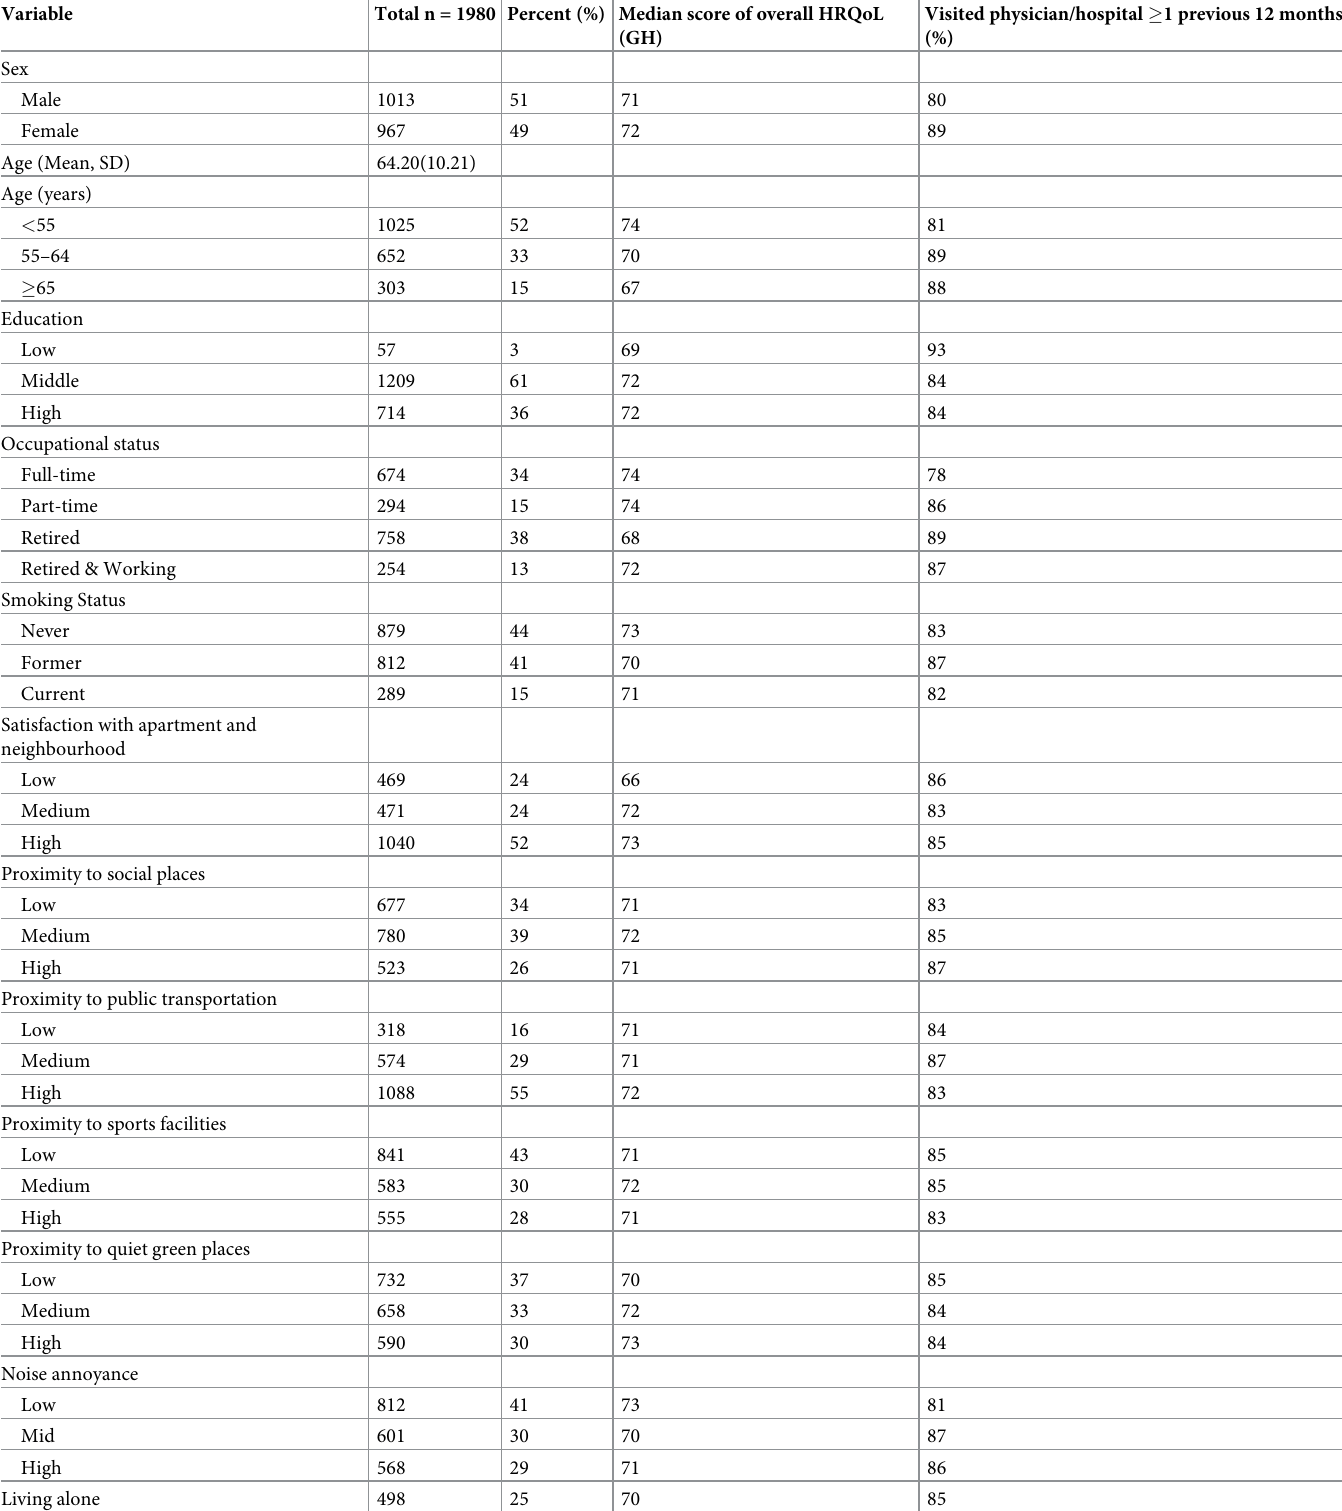
Table 1. Characteristics of the study populations and sub-group specific HRQoL score (GH) and health care utilization.